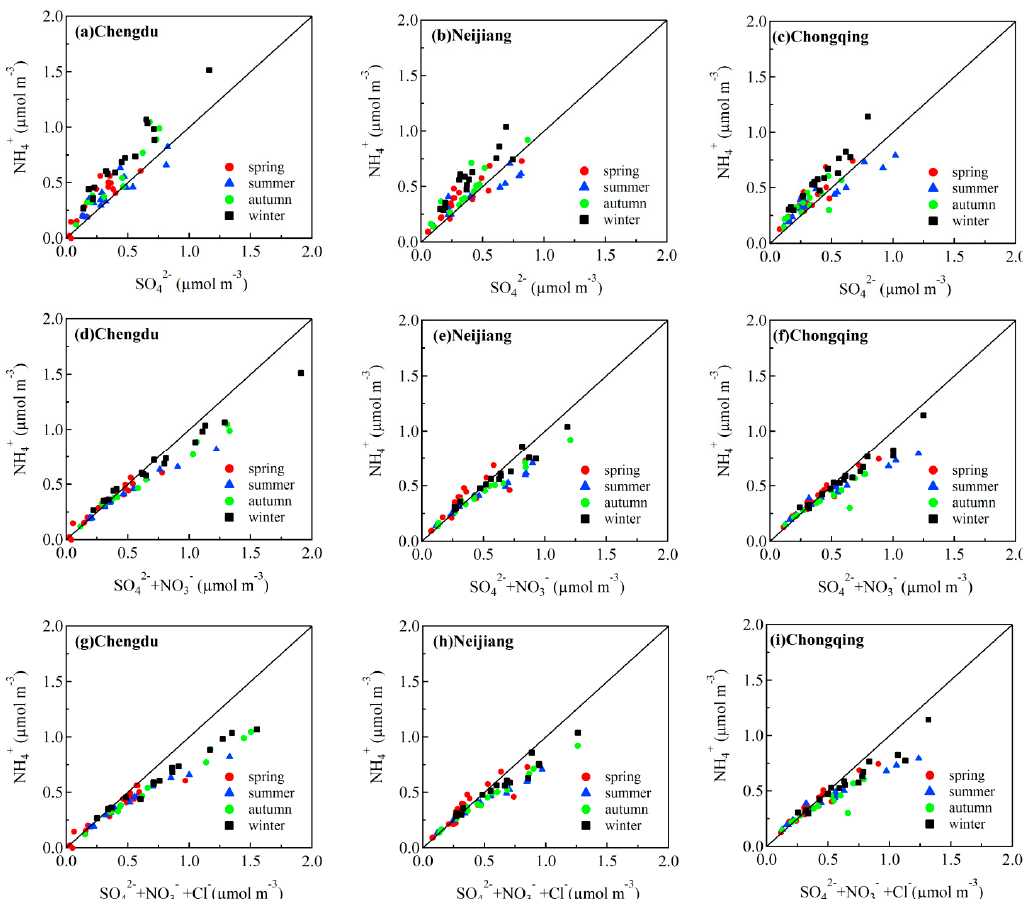
Figure 4. Scatter plots of ammonium and the major acidic anions in PM 2.5 of (a, d, and g) CD, (b, e, and h) NJ, and (c, f, and i) CQ.